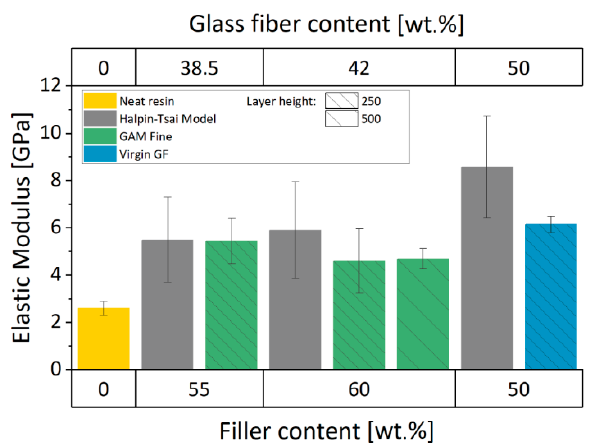
Figure 6. Elastic modulus values for Neat Resin, FIL 100, and GAM Fine-reinforced resins compared with the corresponding Halpin-Tsai Model value.